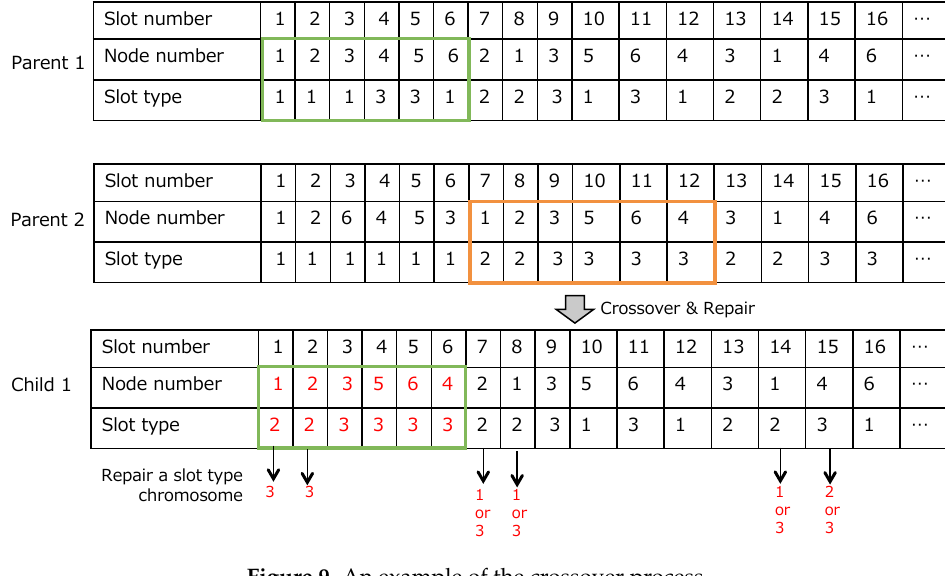
Figure 9. An example of the crossover process.